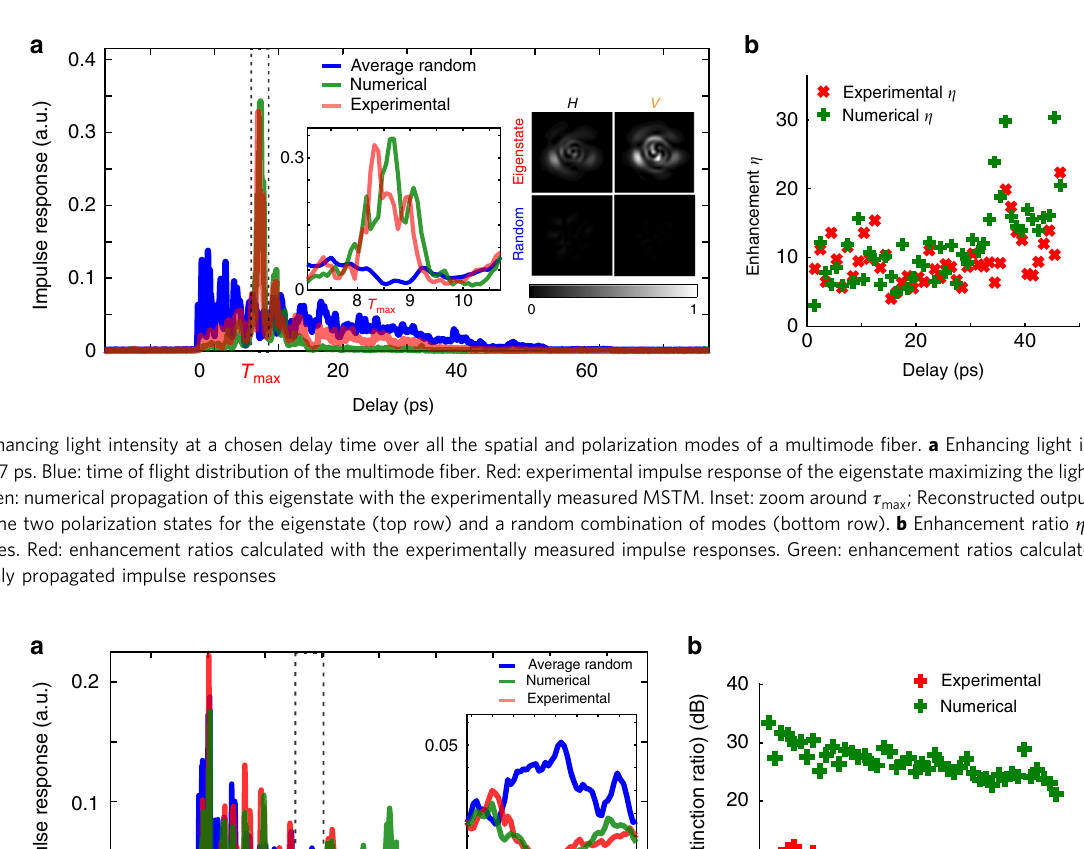
Fig. 3 Attenuating light intensity at a chosen delay time. a Attenuating light intensity at τ min ¼ 19 ps. Blue: time of fl ight distribution of the multimode fi ber. Red: experimental impulse response of the eigenstate minimizing the light intensity at τ min . Green: numerical propagation of this eigenstate with the experimentally measured MSTM. Inset: zoom around τ ( b ) Attenuation ratio ρ for different delay times in logarithm scale. Red: attenuation ratios min calculated with the experimentally measured impulse responses. Green: attenuation ratios calculated with the numerically propagated impulse responses (red markers) with the expected enhancement η numerical ð τ Þ (green markers) for a set of different arrival times